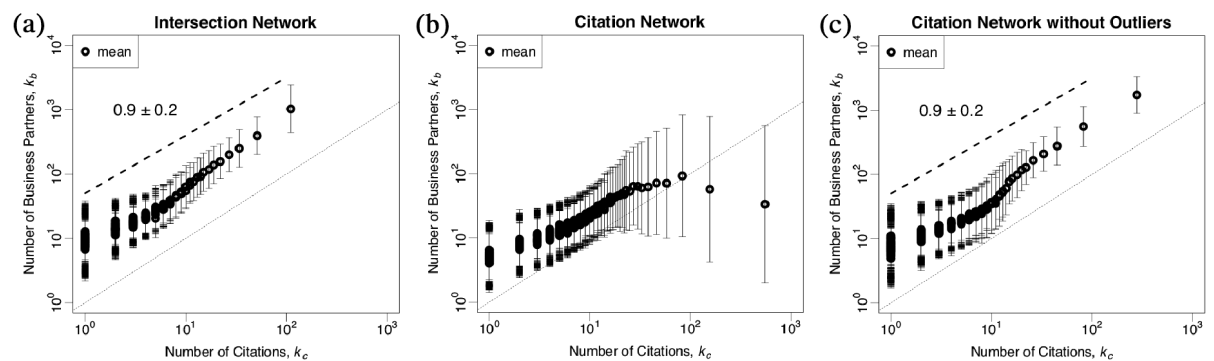
Fig 1. Scaling relations between a mean of pairs of k relation on the intersection network, the citation network, and the citation network without the outliers, respectively. There is a scaling relation such that k / k 0 : 9 � 0 : 2 b c